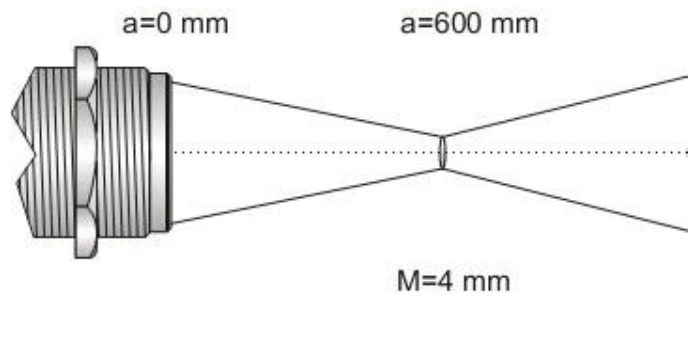
Figure 1. TL-S-25 Infrared Sensor focus (Calex Electronics